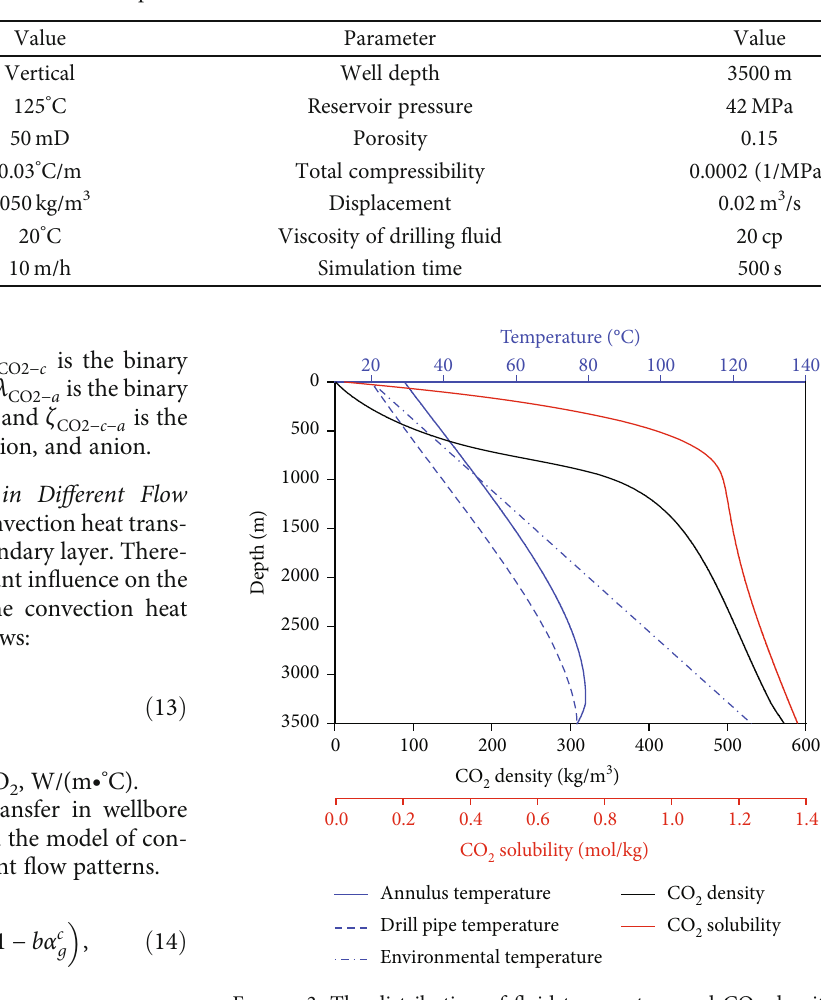
Table 3: Basic parameters for kick simulation.